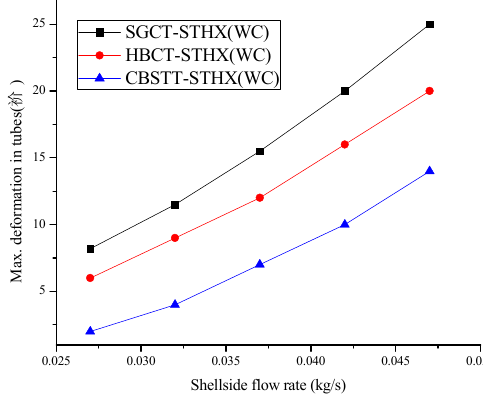
Figure 12. Max deformation in tubes versus mass flow rate.